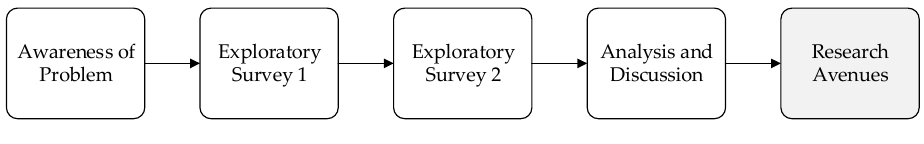
Figure 5. Research